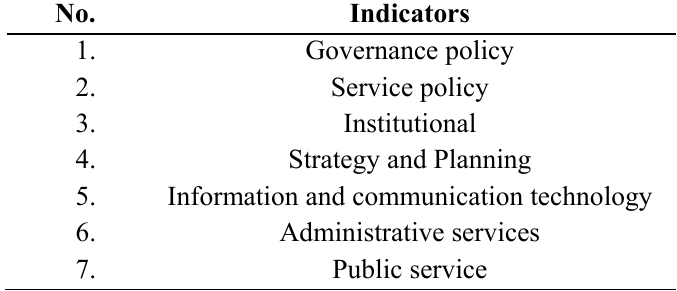
Table 3. Assessment Indicators for Electronic-Based Government Systems [8]